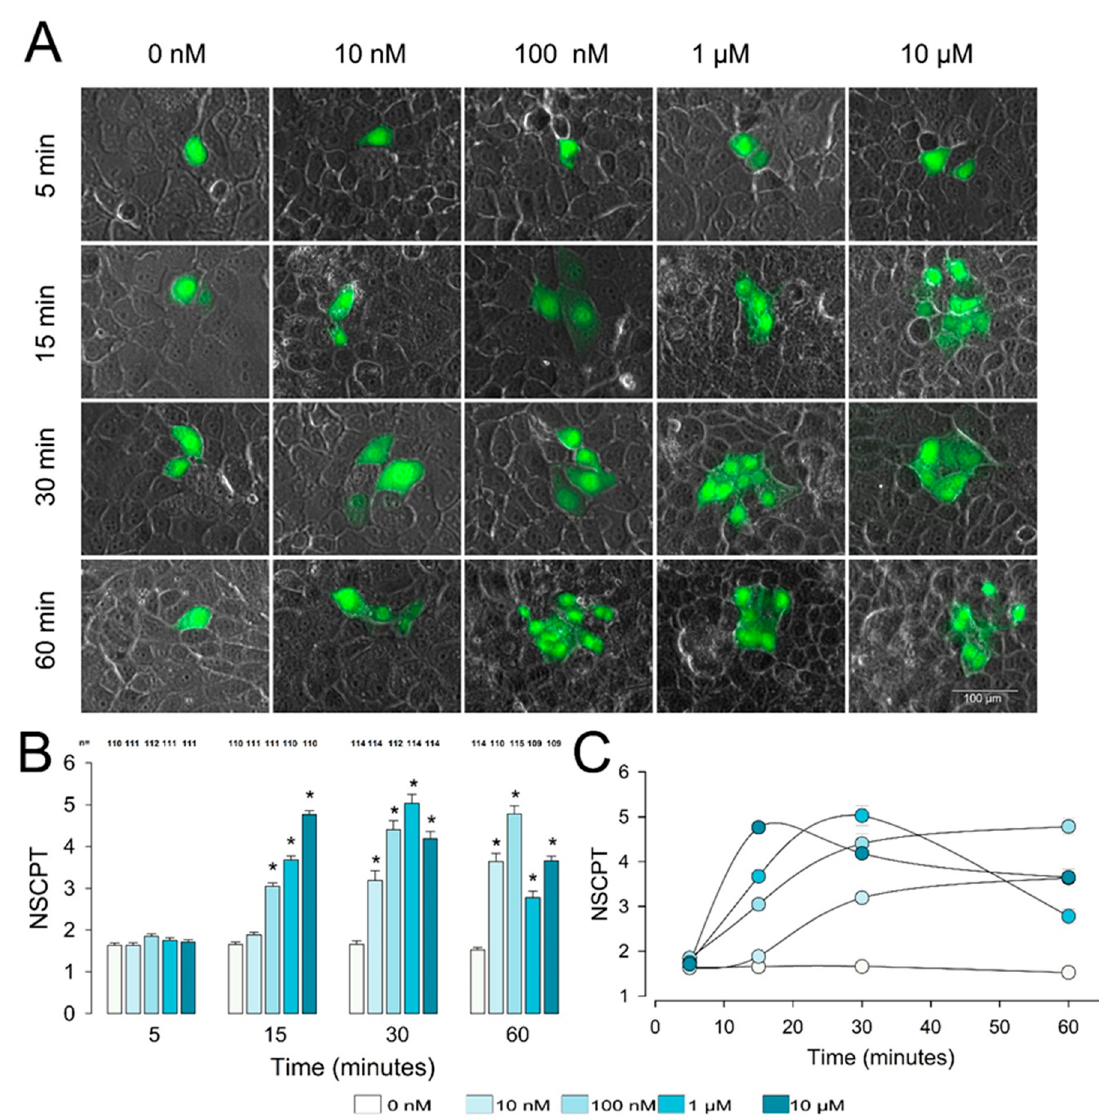
Figure 1. Prostaglandin E2 (PGE2) induces gap junctional intercellular communication in epithelial cells. ( A ). Representative images show clusters of cells stained (green) after one of them was injected with Lucifer yellow. Images were selected to match the median of the number of stained cells per trial (NSCPT) under each experimental condition, as indicated. ( B ) The bar chart compares the average (NSCPT) of the distinct concentrations of PGE2 versus the control (0 nM) at each time tested. The * above bars indicate a statistically significant difference of a given concentration of PGE2 versus the control. The numbers above each bar indicate the number of repeats under each experimental condition. ( C ) A plot of NSCPT vs. time shows the kinetic of the response at each experimental concentration of PGE2. The continuous lines were drawn by smoothing.